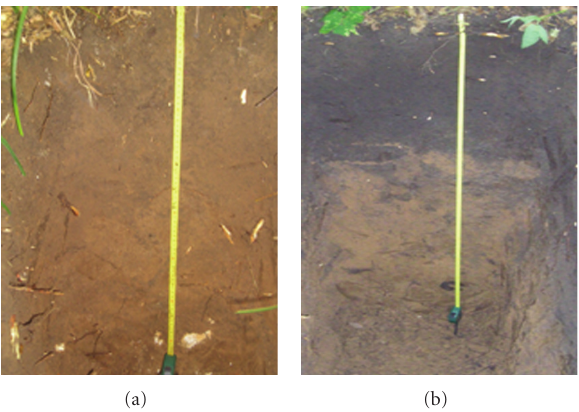
Figure 1: Morphology of two soils investigated: (a) Cambisol and (b)